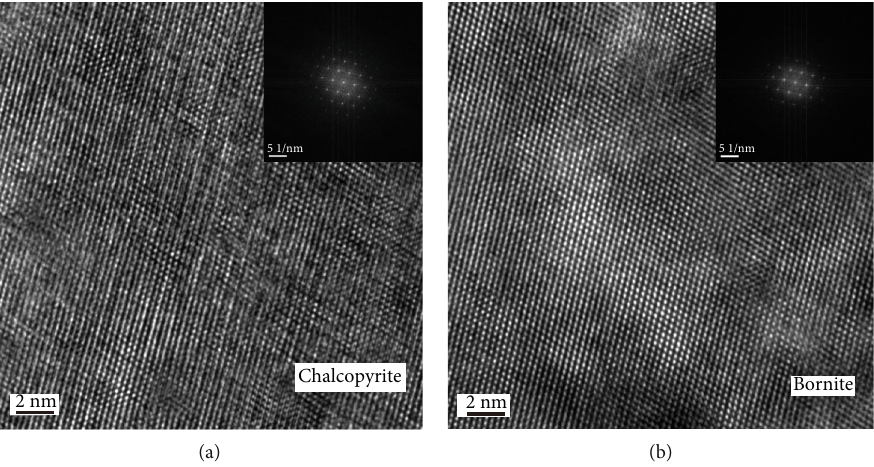
Figure 6: Microstructures of (a) chalcopyrite and (b) bornite in the 109 porphyry Cu deposit, showing that the lattices of these Fe-(Cu)-sul fi des are regularly arranged. The insets show the corresponding SAED